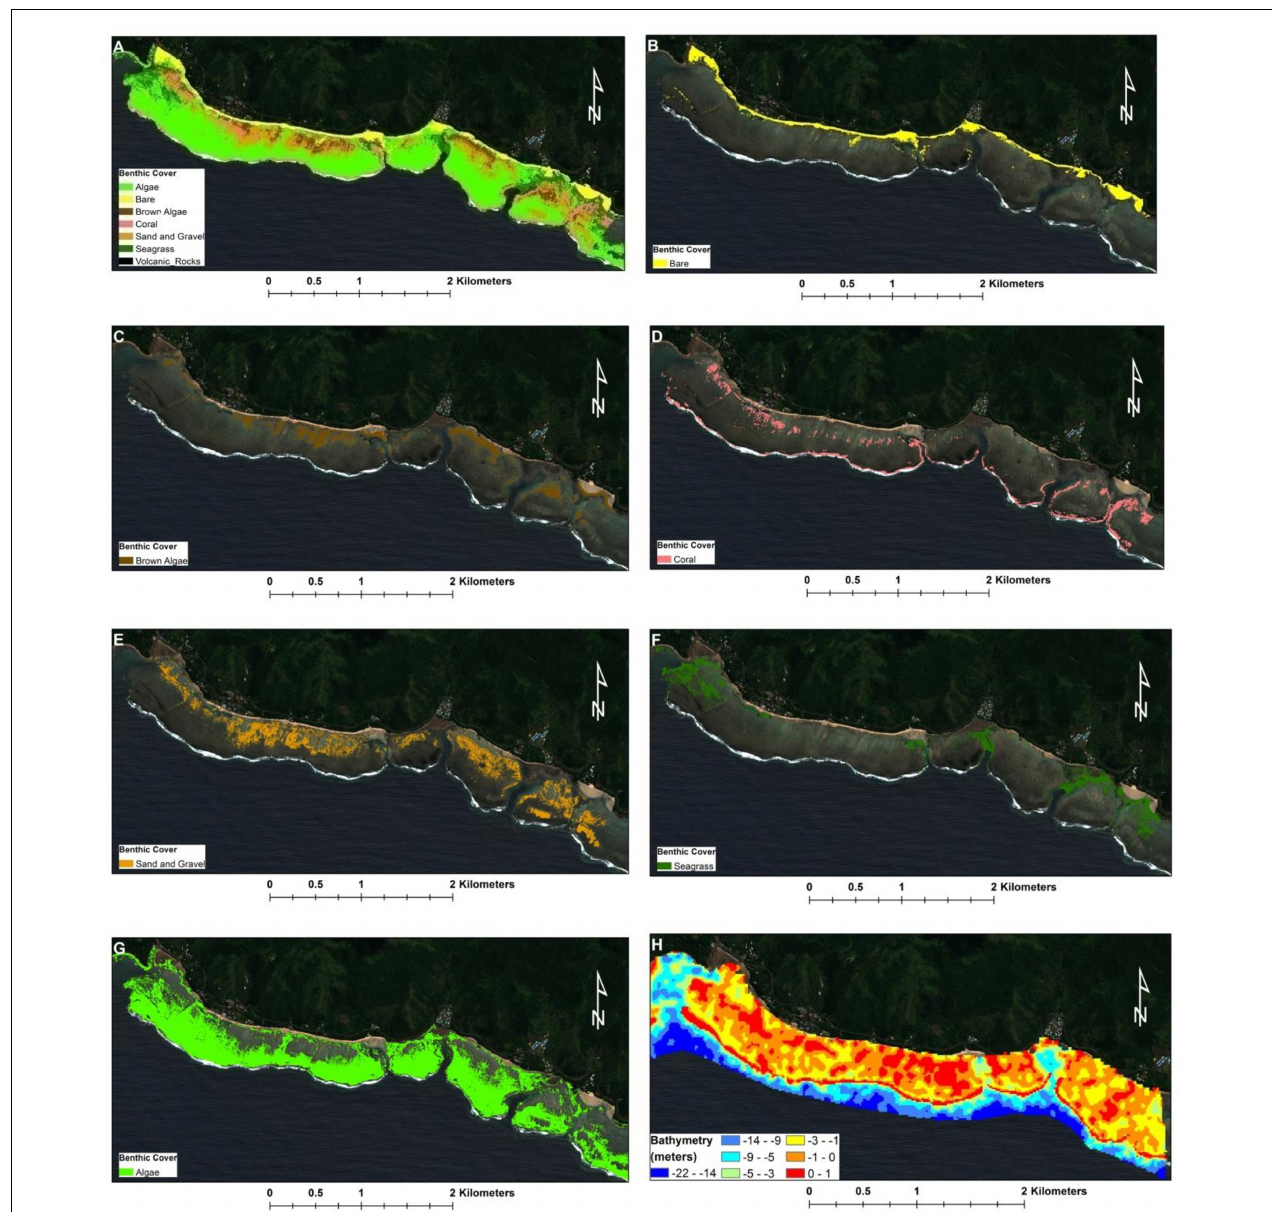
FIGURE 3 | Benthic cover map for Komave coastal habitats. (A) Total benthic cover map with all seven classes represented, (B) bare, (C) brown algae, (D) coral, (E) sand and gravel, (F) sea grass, (G) algae, (H) is the bathymetry 3 map showing the depth distribution of the study